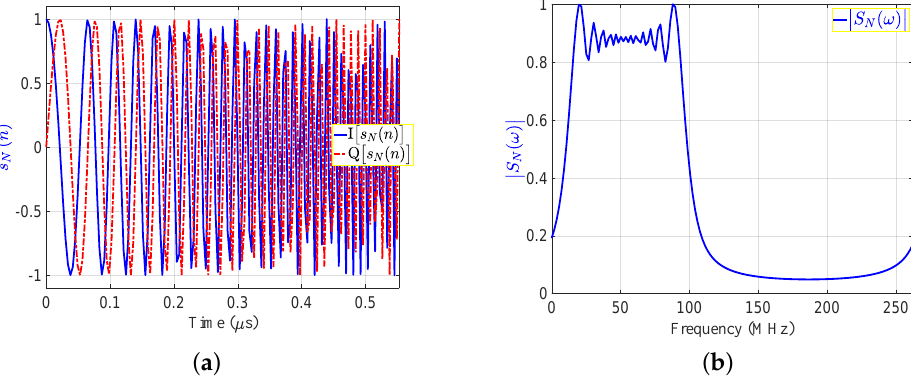
(cid:12) (cid:12) S N